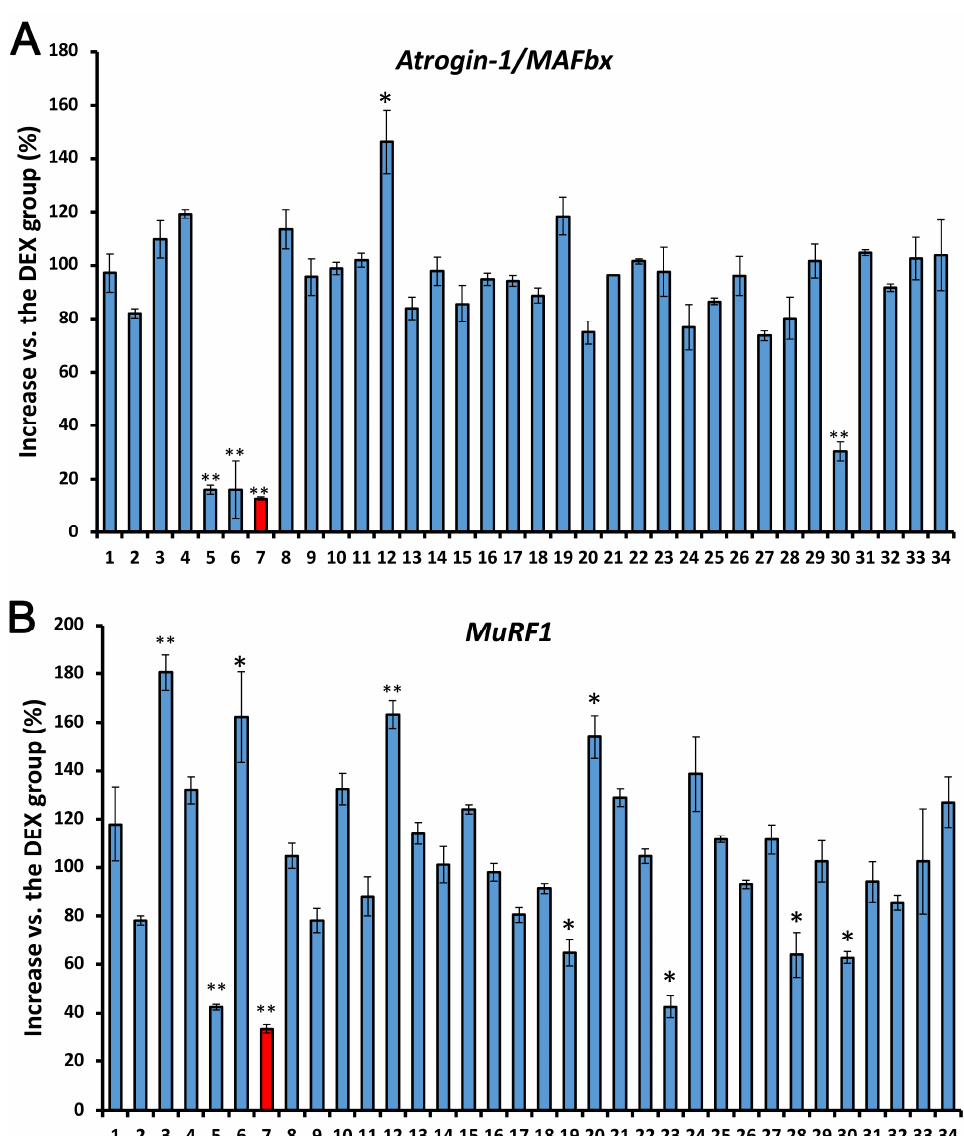
Figure 1. Effect of extracts of 34 spices and herbs on the mRNA expressions of ( A ) atrogin-1/MAFbx and ( B ) MuRF1 in L6 myotubes. When L6 cells reached 90% confluence, the Dulbecco’s modified Eagle’s medium (DMEM) was replaced with 2% fetal bovine serum (differentiation medium), and the cells were further incubated for 9 days. L6 myotubes were then preincubated for 12 h with different concentrations of spices and herbs. Thereafter, dexamethasone (DEX; 10 nM) was added and myotubes were incubated for 12 h. The red columns represent the laurel treatment group. Data are shown as the mean ± standard error (SE) ( n = 4). Statistical significance was determined by Dunnett’s test. * p < 0.05, ** p < 0.01 vs. DEX group.